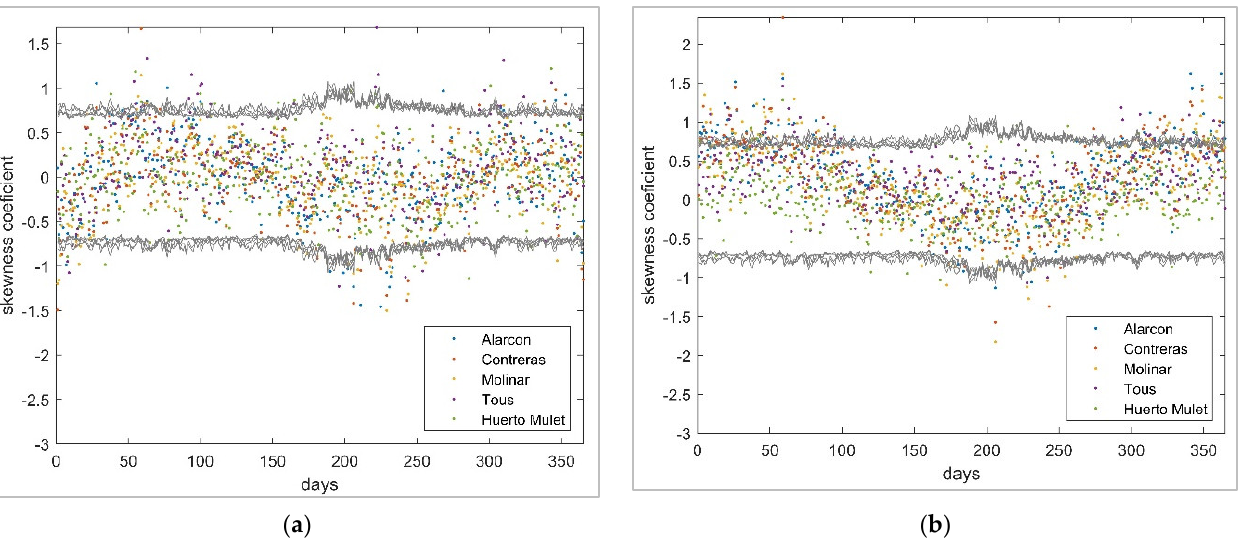
Figure 4. Skewness coefficient (daily average) of normalized series (66 years): ( a ) maximum temperature and ( b ) temperature range. Anderson confidence limits (95%).